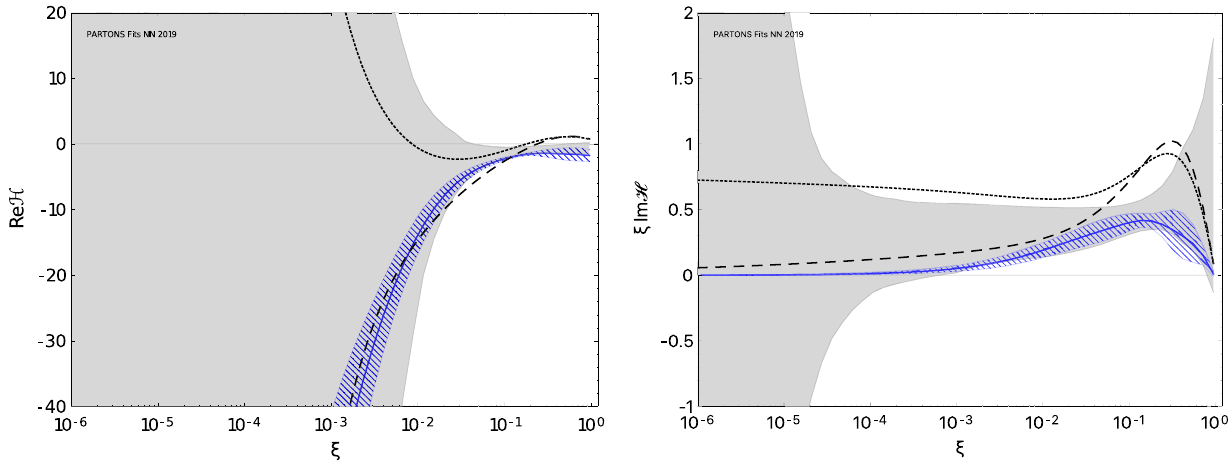
Fig. 16 Real (left) and imaginary (right) parts of the CFF H as a func- tion of ξ for t = − 0 . 3 GeV 2 and Q 2 = 2 GeV 2 . The blue solid line surrounded by the blue hatched band denotes the result of our previ- ous analysis [14]. The depicted uncertainty accounts for uncertainties